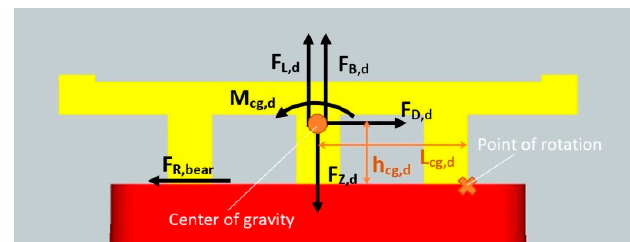
Figure 2. Schematic of forces on the bridge deck. F R,bear is bearing (friction) force. F z,d is weight. F B,d is buoyancy. F L,d is lift. F D,d is drag. M cg,d is the centroidal moment.